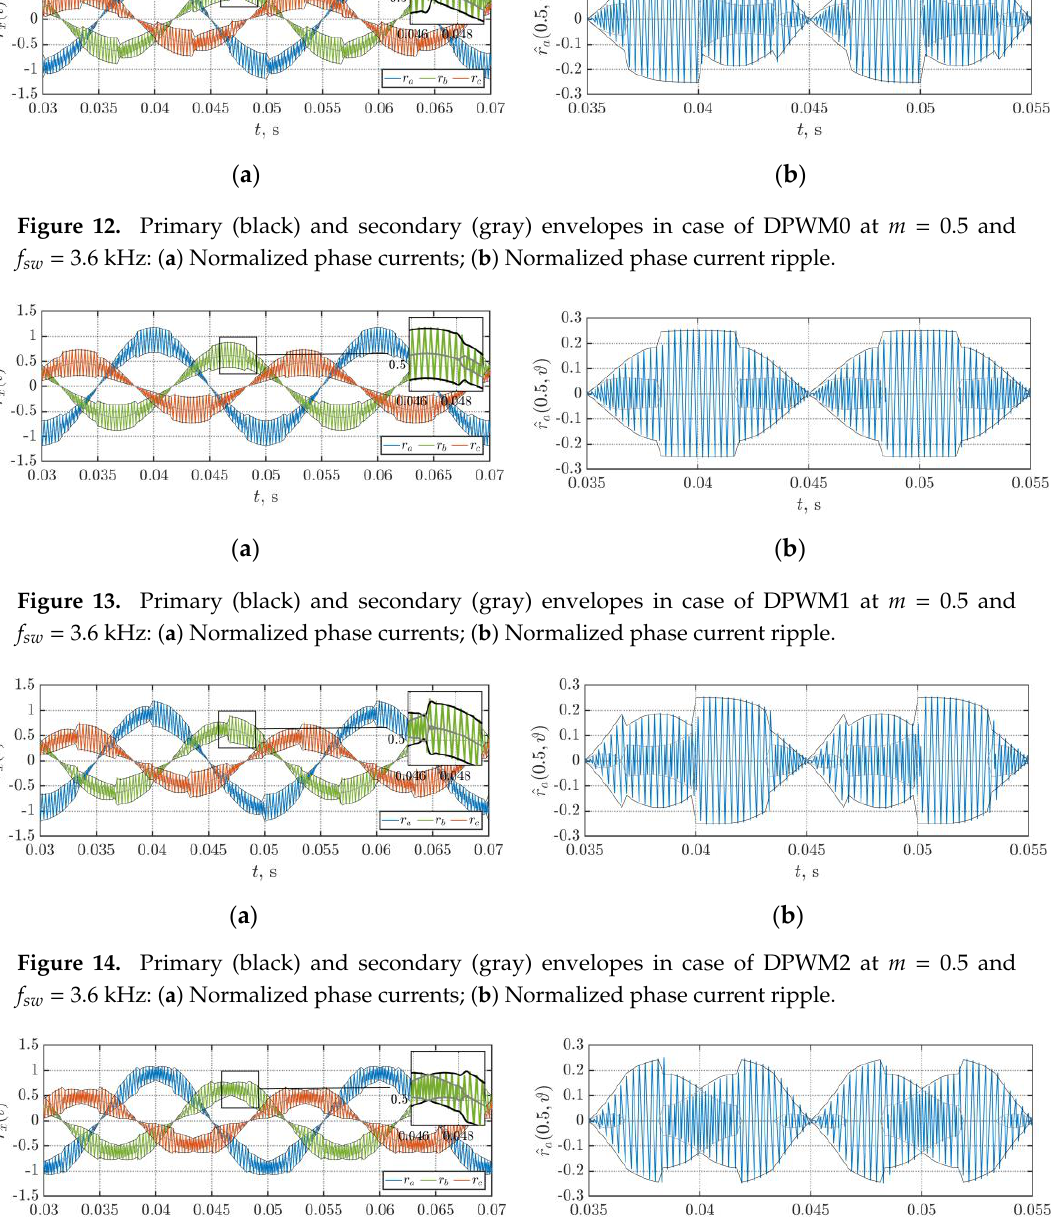
( b ) Figure 11. Primary (black) and secondary (gray) envelopes in case of DPWMMIN at m = 0.5 and f sw = 3.6 kHz: ( a ) Normalized phase currents; ( b ) Normalized phase current ripple. Since DPWM0 (Figure 12), DPWM1 (Figure 13), DPWM2 (Figure 14), and DPWM3 (Figure 15) alternate the positive and the negative clamping, their ripple profiles share part of the DPWMMAX and DPWMMIN contours. Moreover, rearranging sections of the plots in Figures 12b and 14b, it is